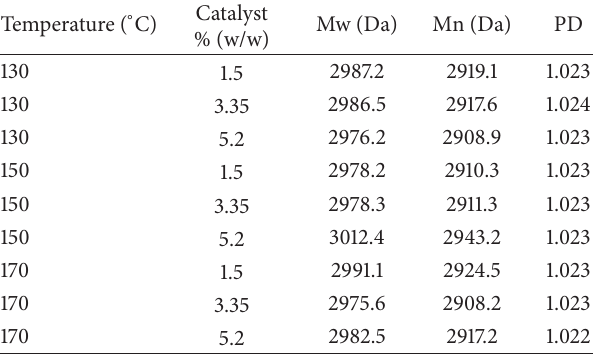
Table 2: Summary table of polydispersity, number, and weight aver- age molecular weights of polyglycerol synthesized at three different temperatures (130, 150, and 170 ∘ C) and catalyst concentrations 1.5% (w/w), 3.35% (w/w), and 5.2%